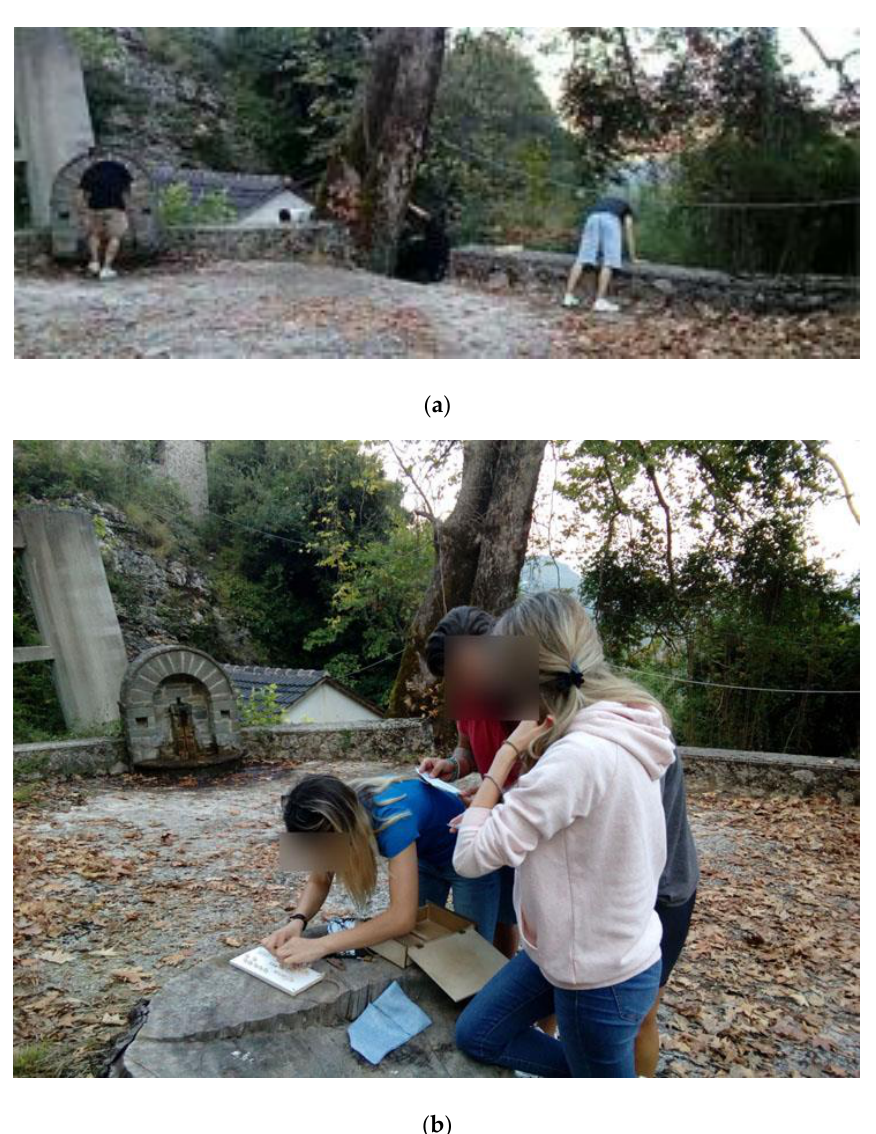
Figure 6. Game conduction. ( a ) Looking for hidden objects; ( b ) Placing letters in label’s recess.